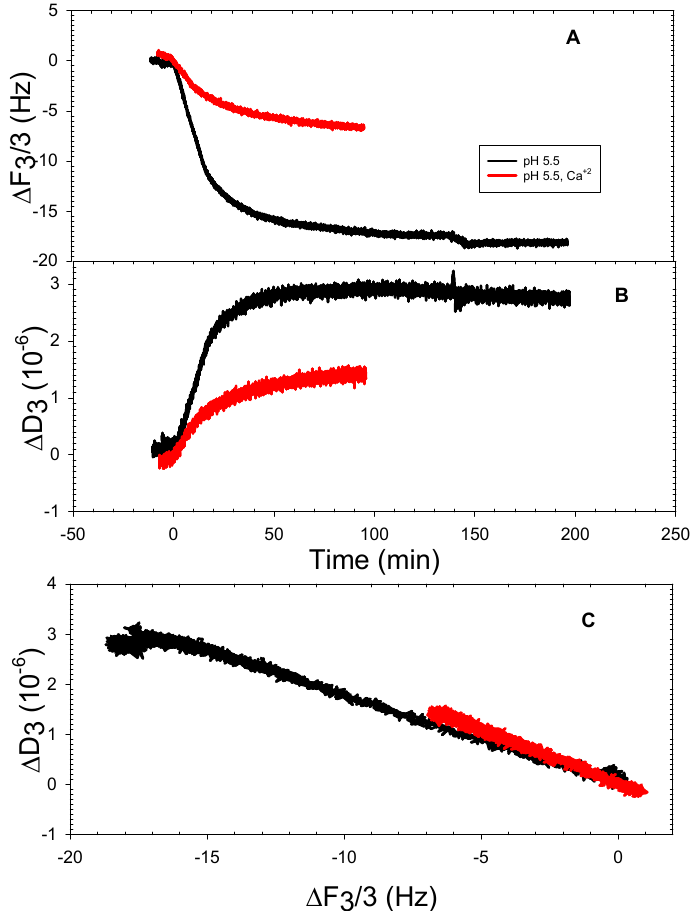
Figure 3. Representative quartz crystal microbalance with dissipation (QCMD) frequency ( A ) and dissipation ( B ) shifts of DOPHT adsorption onto silica at pH 5.5 in the absence and presence of 2 mM CaCl 2 ; ΔF vs. ΔD plot ( C ).